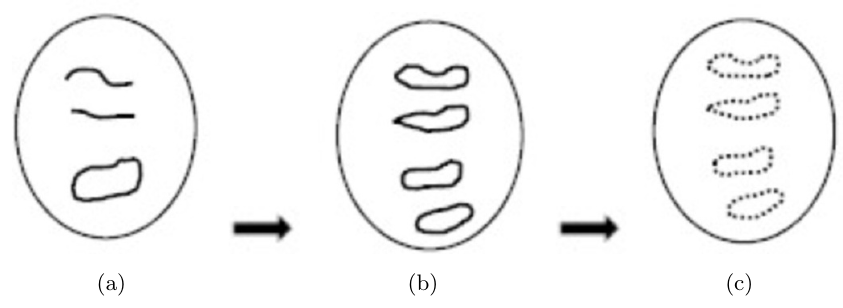
Figure 1 . Open and closed strings (a) to our object formalism (b) and